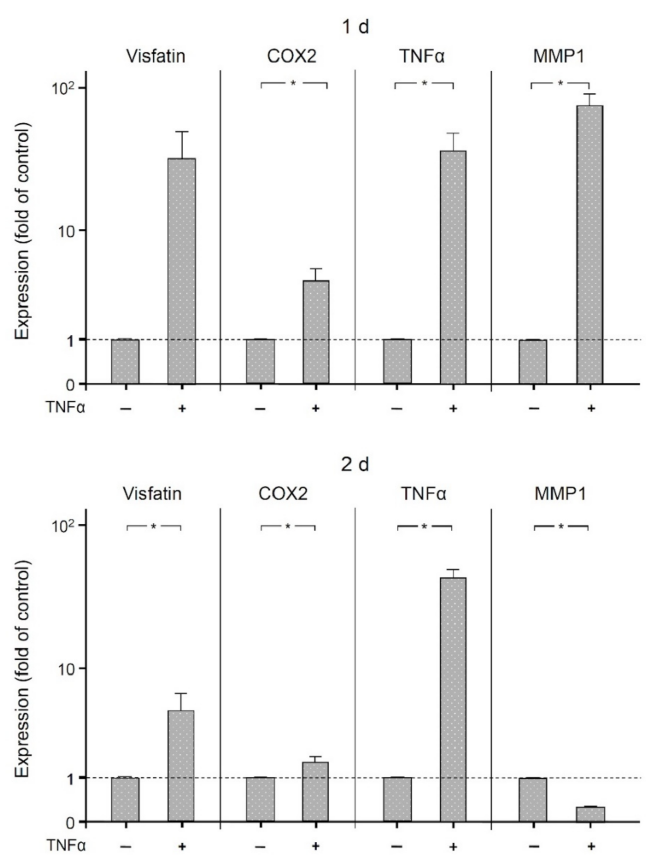
Figure 6. Expression of visfatin, COX2, TNF α , and MMP-1 in the presence and absence of TNF α (1 ng/mL) in human macrophages at (1 d) and (2 d), analyzed by real-time PCR. Mean ± SEM. * significant ( p < 0.05) difference between